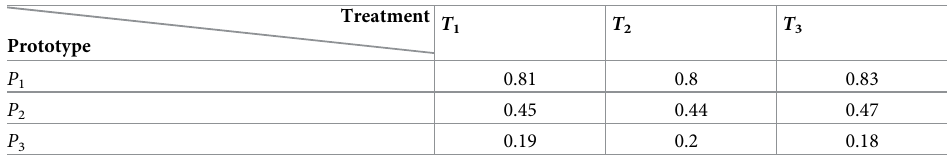
Table 2. Low variance within